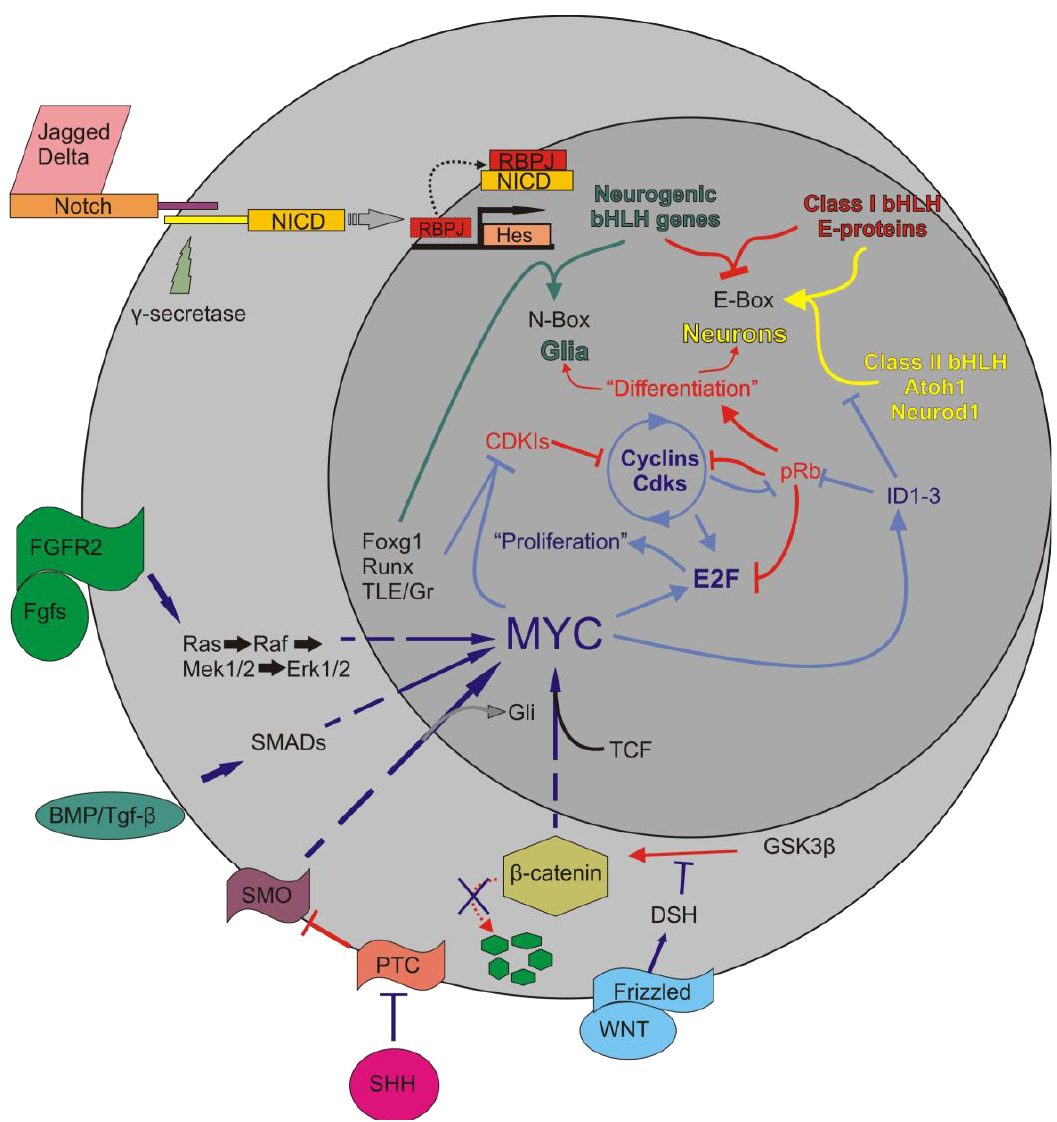
Figure 4. The interactions of Myc in the body are complex. Upon activation of Notch by Jagged or Delta, the Notch IntraCellular D (cid:82)(cid:80)(cid:68)(cid:76)(cid:81)(cid:3)(cid:11)(cid:49)(cid:44)(cid:38)(cid:39)(cid:12)(cid:3)(cid:76)(cid:86)(cid:3)(cid:70)(cid:79)(cid:72)(cid:68)(cid:89)(cid:72)(cid:71)(cid:3)(cid:69)(cid:92)(cid:3)(cid:534) -secretase. NICD translocates to the nucleus to form a complex with RBPJ to positively regulate the transcription of the Hes family of bHLH TFs [63]. Myc is regulated by a number of (cid:83)(cid:68)(cid:87)(cid:75)(cid:90)(cid:68)(cid:92)(cid:86)(cid:15)(cid:3)(cid:76)(cid:81)(cid:70)(cid:79)(cid:88)(cid:71)(cid:76)(cid:81)(cid:74)(cid:3)(cid:87)(cid:75)(cid:72)(cid:3)(cid:58)(cid:81)(cid:87)(cid:18)(cid:533) -catenin pathway, Tgf- (cid:533)(cid:3)(cid:82)(cid:85)(cid:3)(cid:37)(cid:80)(cid:83)(cid:18)(cid:54)(cid:80)(cid:68)(cid:71)(cid:15)(cid:3)(cid:41)(cid:74)(cid:73)(cid:18)(cid:40)(cid:85)(cid:78)(cid:20)(cid:18)(cid:21)(cid:15)(cid:3)(cid:68)(cid:81)(cid:71)(cid:3)(cid:87)(cid:75)(cid:72)(cid:3) Shh/Smo pathways. Once activated, Myc interacts with partner proteins to regulate a number of downstream effectors, including the cyclins, E2Fs, IDs, CDKIs, and various microRNAs. This regulation leads to the inhibition of class II bHLH TFs from binding to the E-proteins which then allows the Hes family to occupy the E-proteins. It also leads to the removal of pRb from E2F and allows E2F to bind S-phase promoting genes. The larger circle represents the cell as a whole while the smaller circle is the nucleus. Arrows indicate upregulation while blunted lines represent inhibition. Red indicates pathways favoring differentiation, blue indicates pathways favoring proliferation. Modified after